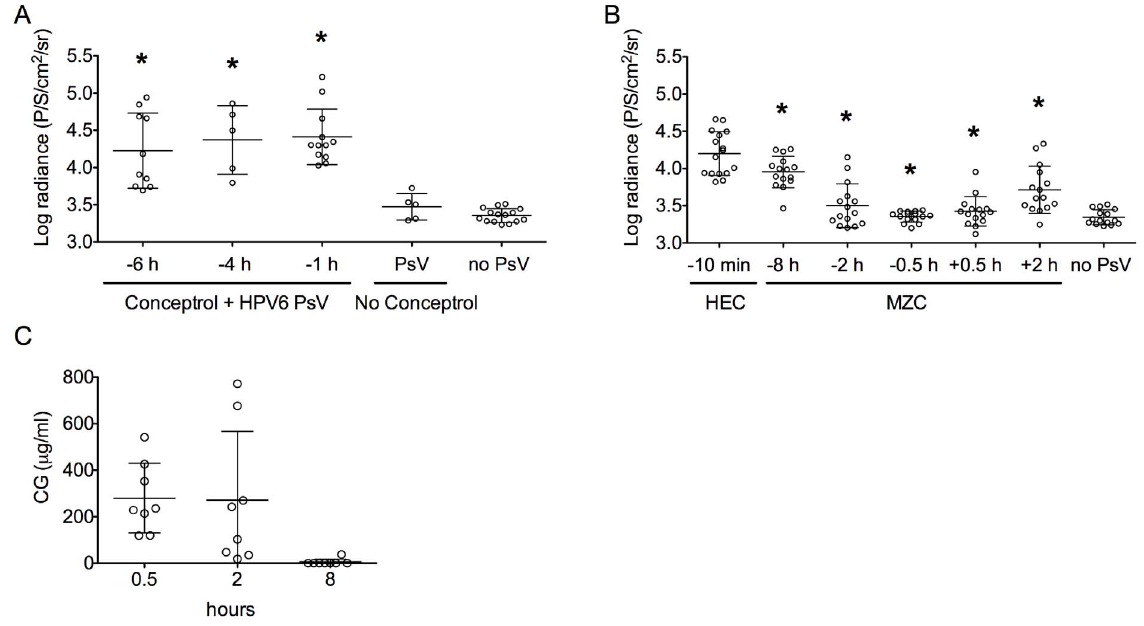
Figure 7. MZC prevents HPV-16 PsV anorectal infection in mice. A) Ketamine/xylazine-anesthetized Balb/C mice were treated in the anorectal area with Conceptrol or D-PBS (no Conceptrol). Mice were challenged with HPV-16 PsV to determine the optimal time for conceptrol treatment that gives the best luminescence signal. B) Ketamine/xylazine-anesthetized Balb/C mice received Conceptrol in the anorectal area and were treated with the indicated formulations (HEC placebo for HPV-16 PsV control or MZC) in the anorectal area at different time points before and after HPV-16 PsV challenge (15 animals/treatment). (A and B) In vivo luciferase expression was measured 48 h after challenge using the IVIS Lumina and is expressed as mean luminescence in photons per second per centimeter square per steridian + SD (*P , 0.05 vs. HEC, Mann Whitney U test). C) CG PK in rectal washes from mice treated with MZC formulation was determined at 0.5, 2, and 8 h (n=6 or 8 per time point) after MZC application. The graph shows CG concentration (mean m g/ml 6 SD) per time